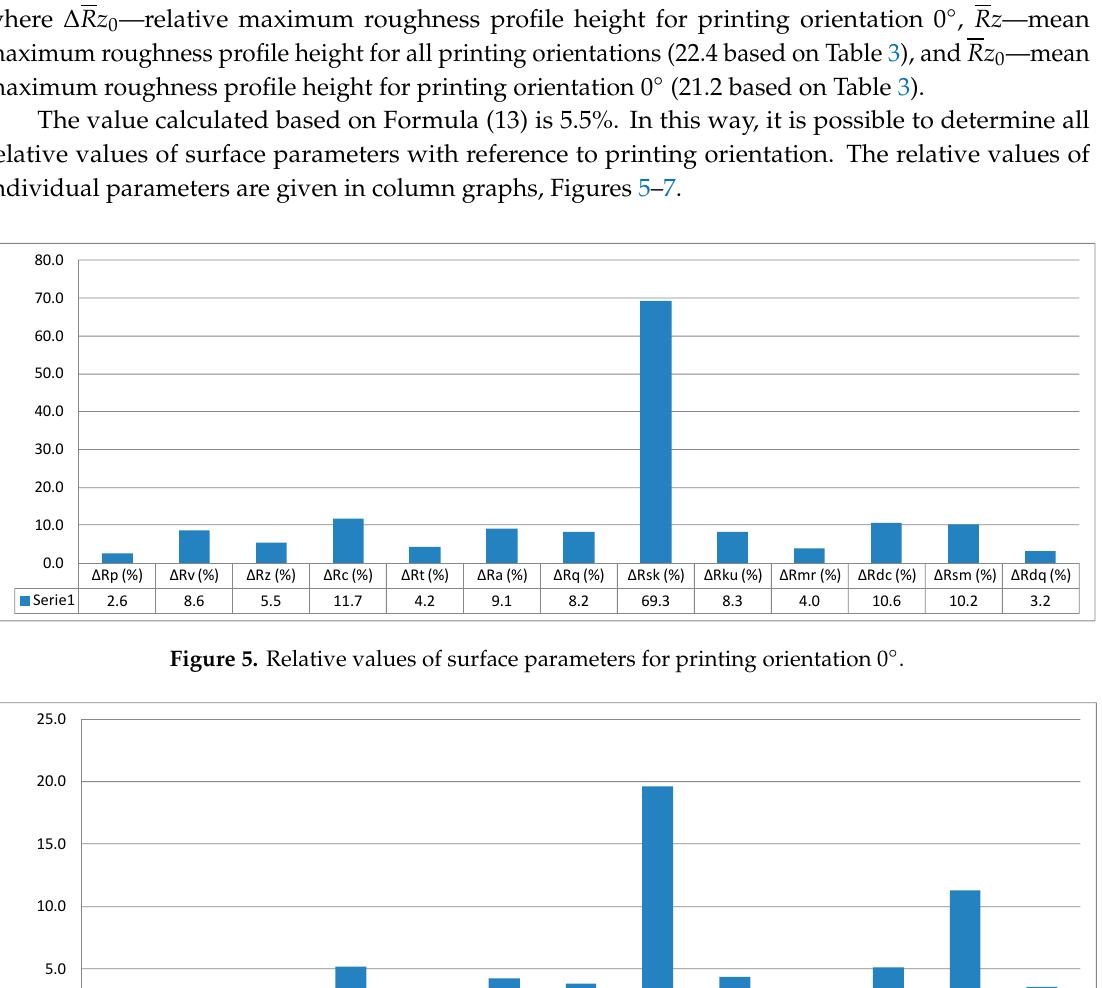
—relative value of surface parameters for individual orientations of printing; X —mean value of a parameter for all orientations of printing ; (cid:1850) (cid:2868) —mean value of the measured parameters for printing orientation 0°; 45 X —mean value of the measured parameters for printing orientation 45°; and